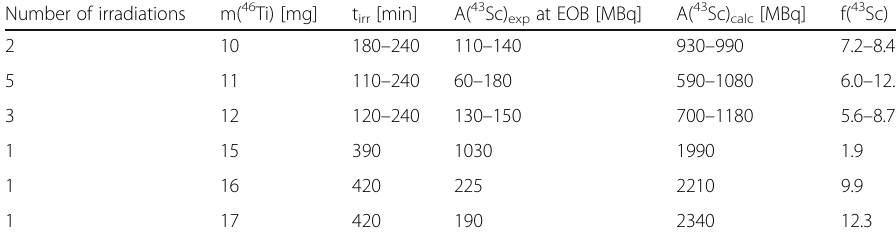
Table 1 Comparison between the experimental A( 43 Sc) exp and the calculated activities A( 43 Sc) calc , obtained from proton irradiations of enriched 46 Ti targets, measured at EOB Number of